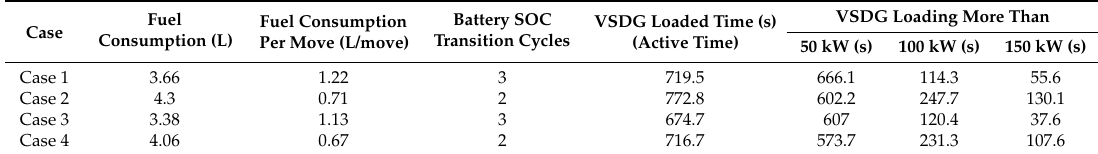
Table 3. Diesel consumption and generator